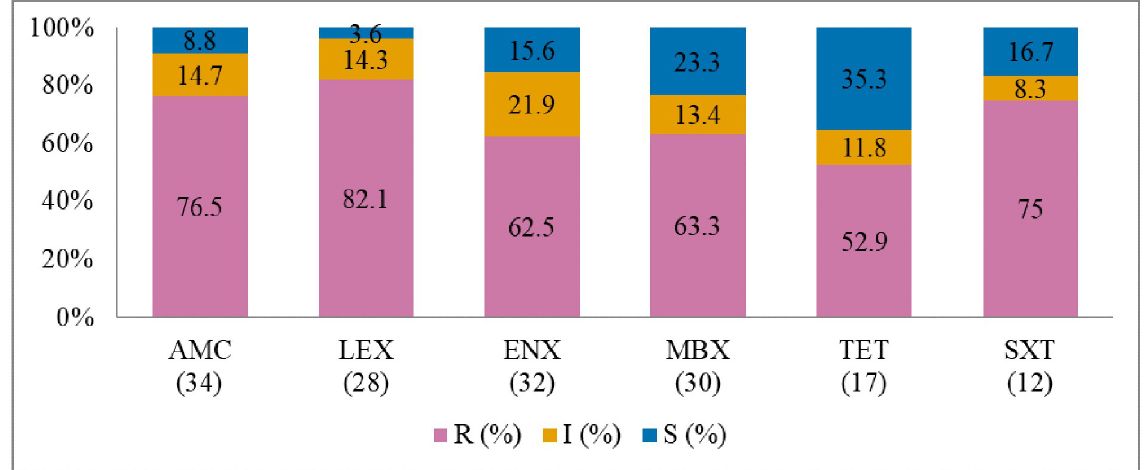
Fig 8. Antibiotic susceptibility pattern from Escherichia coli isolates from diseased dogs (January 2015-December 2017). R–resistance; I- intermediate; S–susceptible; AMC–amoxicillin/clavulanic acid; LEX–cephalexin; ENX–enrofloxacin; MBX–marbofloxacin; TET–tetracycline; SXT–trimethoprim-sulfamethoxazole. Numbers inside brackets ‘()’ indicate the total number of tested isolates for each antibiotic.